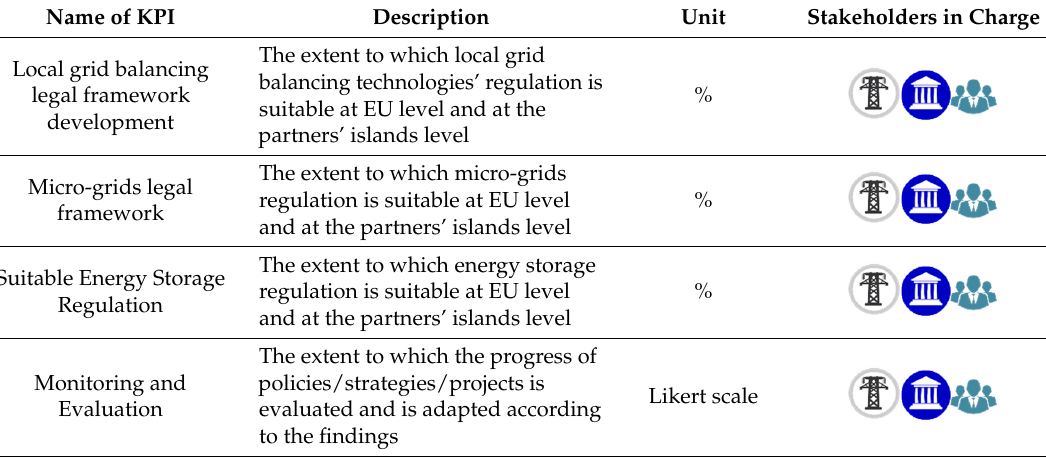
Table 8. List of Legal KPIs. Table 6. List of Economic KPIs. Table 8. List of Legal KPIs. Table 8. List of Legal KPIs.